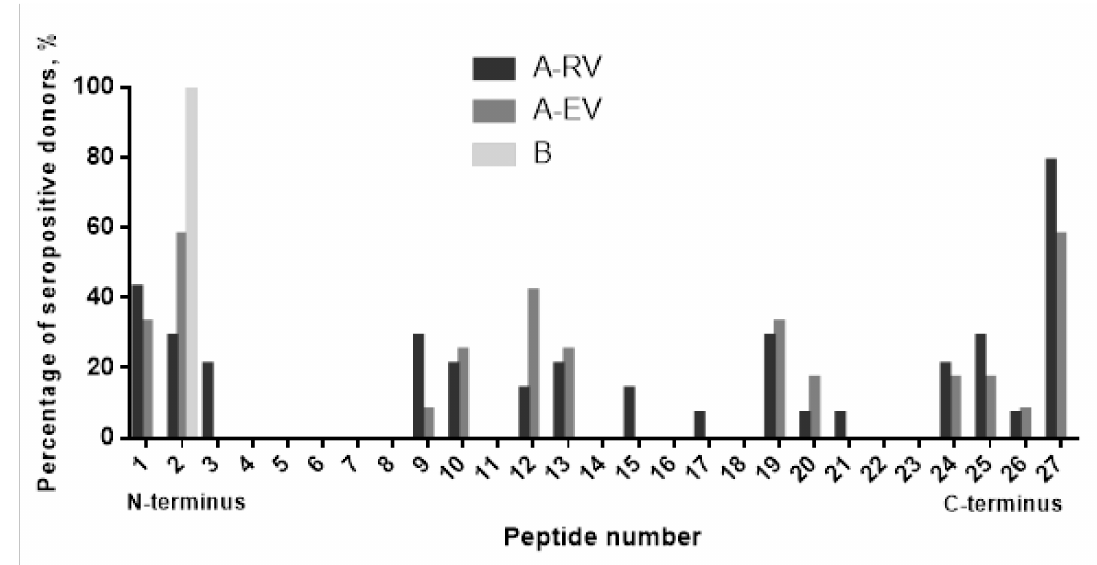
Figure 5. F1 antigen B-cell epitope mapping with sera from LPV-vaccinated donors. A library of 27 peptides designed as 14- and 17-mers with 11 overlaps was used to identify immunoreactive epitopes against sera from donors vaccinated with LPV with di ff erent post-immunization periods (A-RV and A-EV groups). The only serum suitable for peptide analysis among the sera with the positive reaction to recombinant F1 in ELISA of the group B (unvaccinated individuals) reacted with peptide 2 corresponding to the part of the leader amino-acid sequence. A signal was considered positive when it reached the cuto ff value of twice the background optical density (OD). The background OD was the mean of the lowest 50% of all OD values obtained for all peptides and control wells with that particular serum as described by us previously